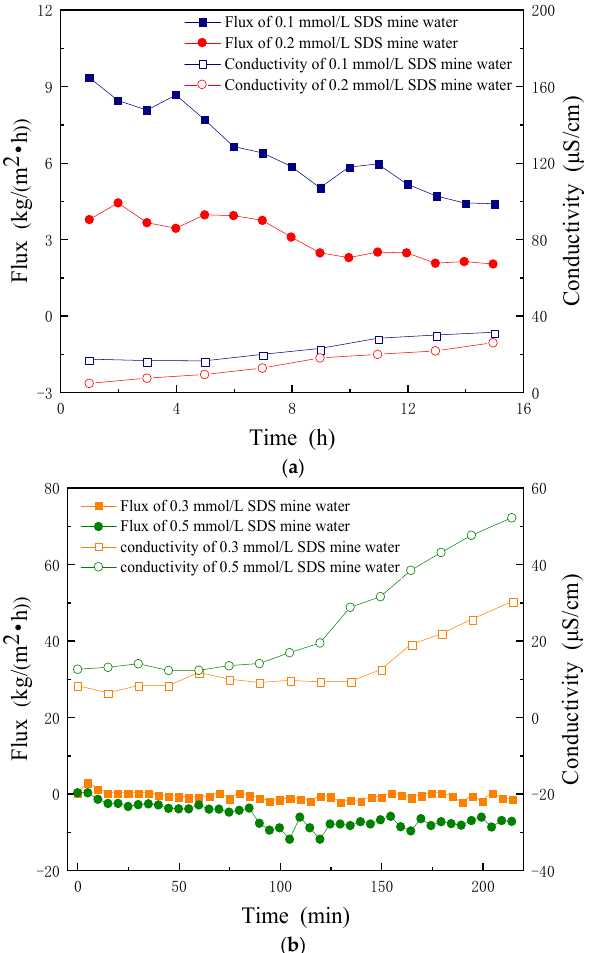
Figure 11. Flux and conductivity variation of PVDF-H membrane in the treatment of mine water ( a ) Containing 0.1 and 0.2 mmol/L SDS, ( b ) Containing 0.3 and 0.5 mmol/L SDS by DCMD. When the PVDF-H membrane was used to treat high salinity mine water containing 0.1 and 0.2 mmol/L SDS, the flux decreased by 37.8% and 40% respectively within 10 h (Figure 11). When the PVDF-H membrane was used to treat high salinity mine water con- taining 0.3 mmol/L SDS, it will be wetted within 100 min. In contrast, the flux of mine water containing 0.1 and 0.2 mmol/L SDS treated with the PVDF-O membrane decreased by only 14% and 19.4%, the conductivity of produced water did not increase significantly within 10 h of treatment of mine water containing 0.3 mmol/L SDS, and the content of Ca element on the membrane surface decreased to 5.9%, indicating that the introduction of low surface energy substances enhanced the anti-wetting property of the membrane (Fig- ure 12).